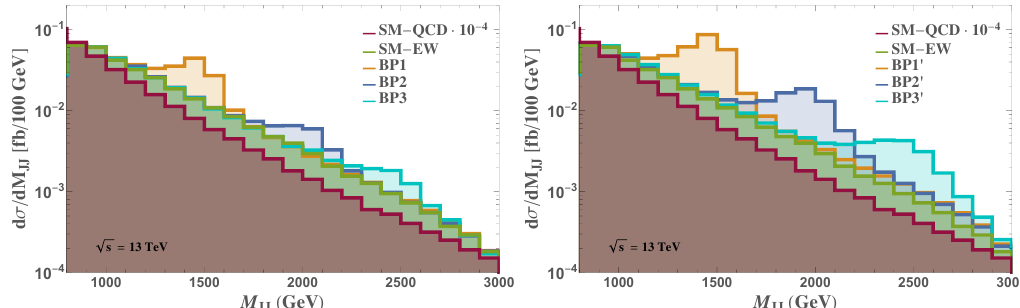
Figure 3 . Predictions of the cross sections distributions of JJjj events with the invariant mass of the fat jet pair, M JJ , after jet reconstruction, using MadGraph+PYTHIA+DELPHES with the anti- k T algorithm. The rates for the EW background (SM-EW), the pure QCD background (SM- 4 ) and the selected signal scenarios for the vector resonances given QCD, scaled down by a factor 10 (cid:0) by the BP’s de(cid:12)ned in table 1 are included. The cuts in eq. (3.3) and eq. (3.4) have been applied. the thin-jet one, R = 0 : 5 is required, whereas for the fat jet one, R = 0 : 8 is required. Regarding the cuts on the reconstructed jets, we (cid:12)rst apply the following set of initial cuts to the thin jets and to the fat jets,